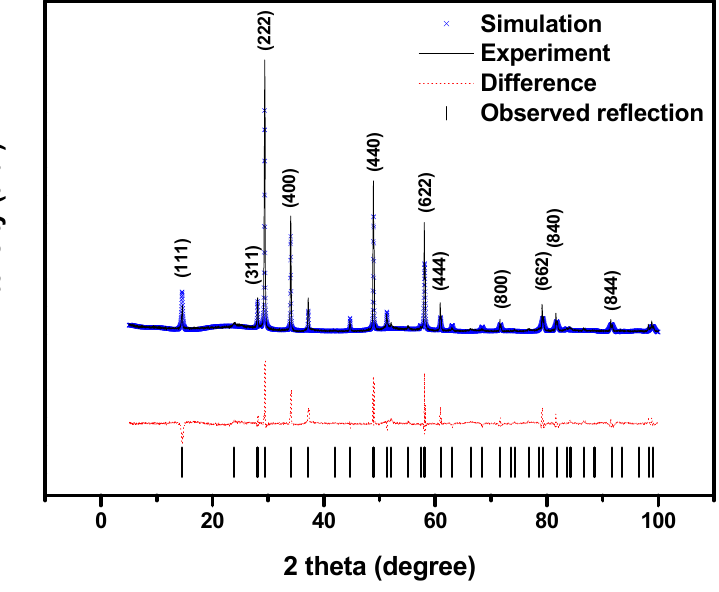
Figure 2. X-ray powder diffraction pattern and Rietveld refinements of Bi by a solid-state reaction method at 1,100 °C.